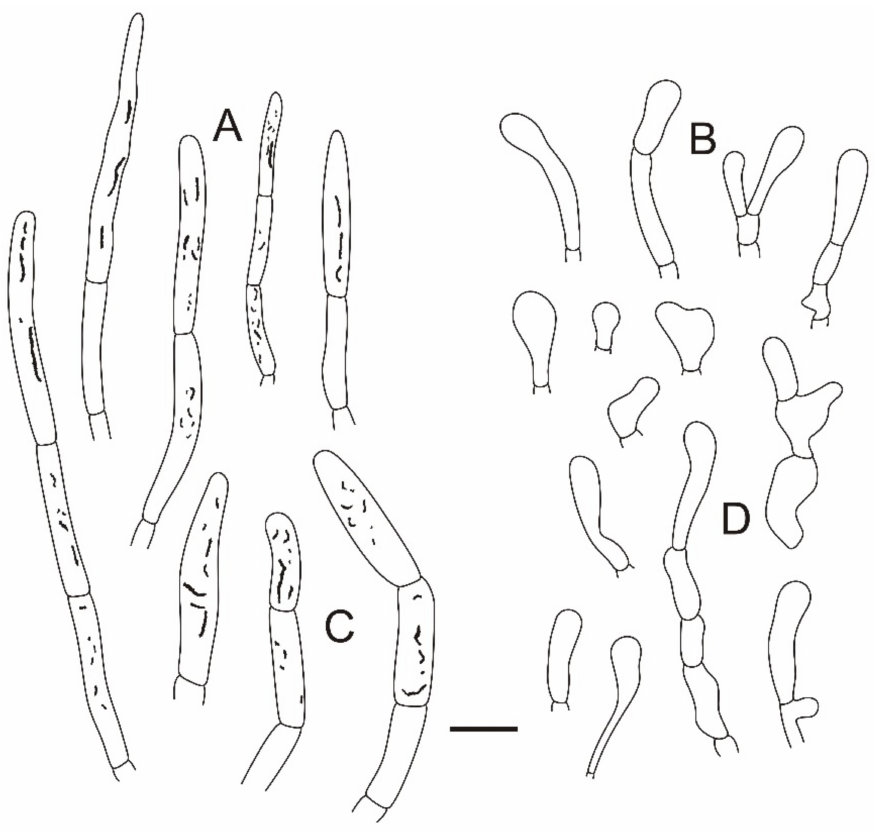
Figure 5. Microscopic features of Russula miyunensis (BJTC Z1355). ( A ) Primordial hyphae near the pileus margin. ( B ) Hyphal terminations near the pileus margin. ( C ) Primordial hyphae near the pileus center. ( D ) Hyphal terminations near the pileus center. Scale bar: 10 µ m.